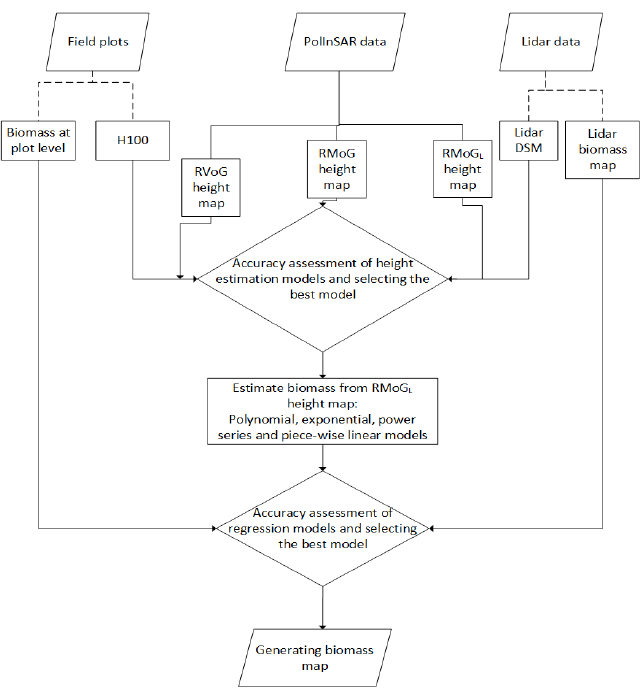
Figure 1. Flowchart of the methodology used in this study.